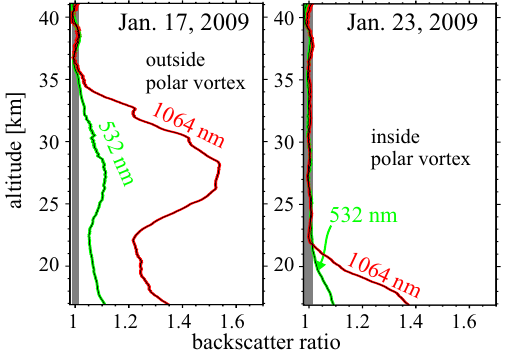
Fig. 8. Aerosol backscatter ratio during the measurements on 17 and 23 January 2009. The gray vertical bar indicates the aerosol free sig- nal ± 1%. The measurement uncertainty is indicated by the thick- ness of the green and red lines. The aerosol contribution to the signal was less than 1% at 532nm for altitudes above 34km and 22km on 17 and 23 January, respectively. The data is smoothed using a running mean of about 2km. A recent description of the analysis method can be found in Jumelet et al.